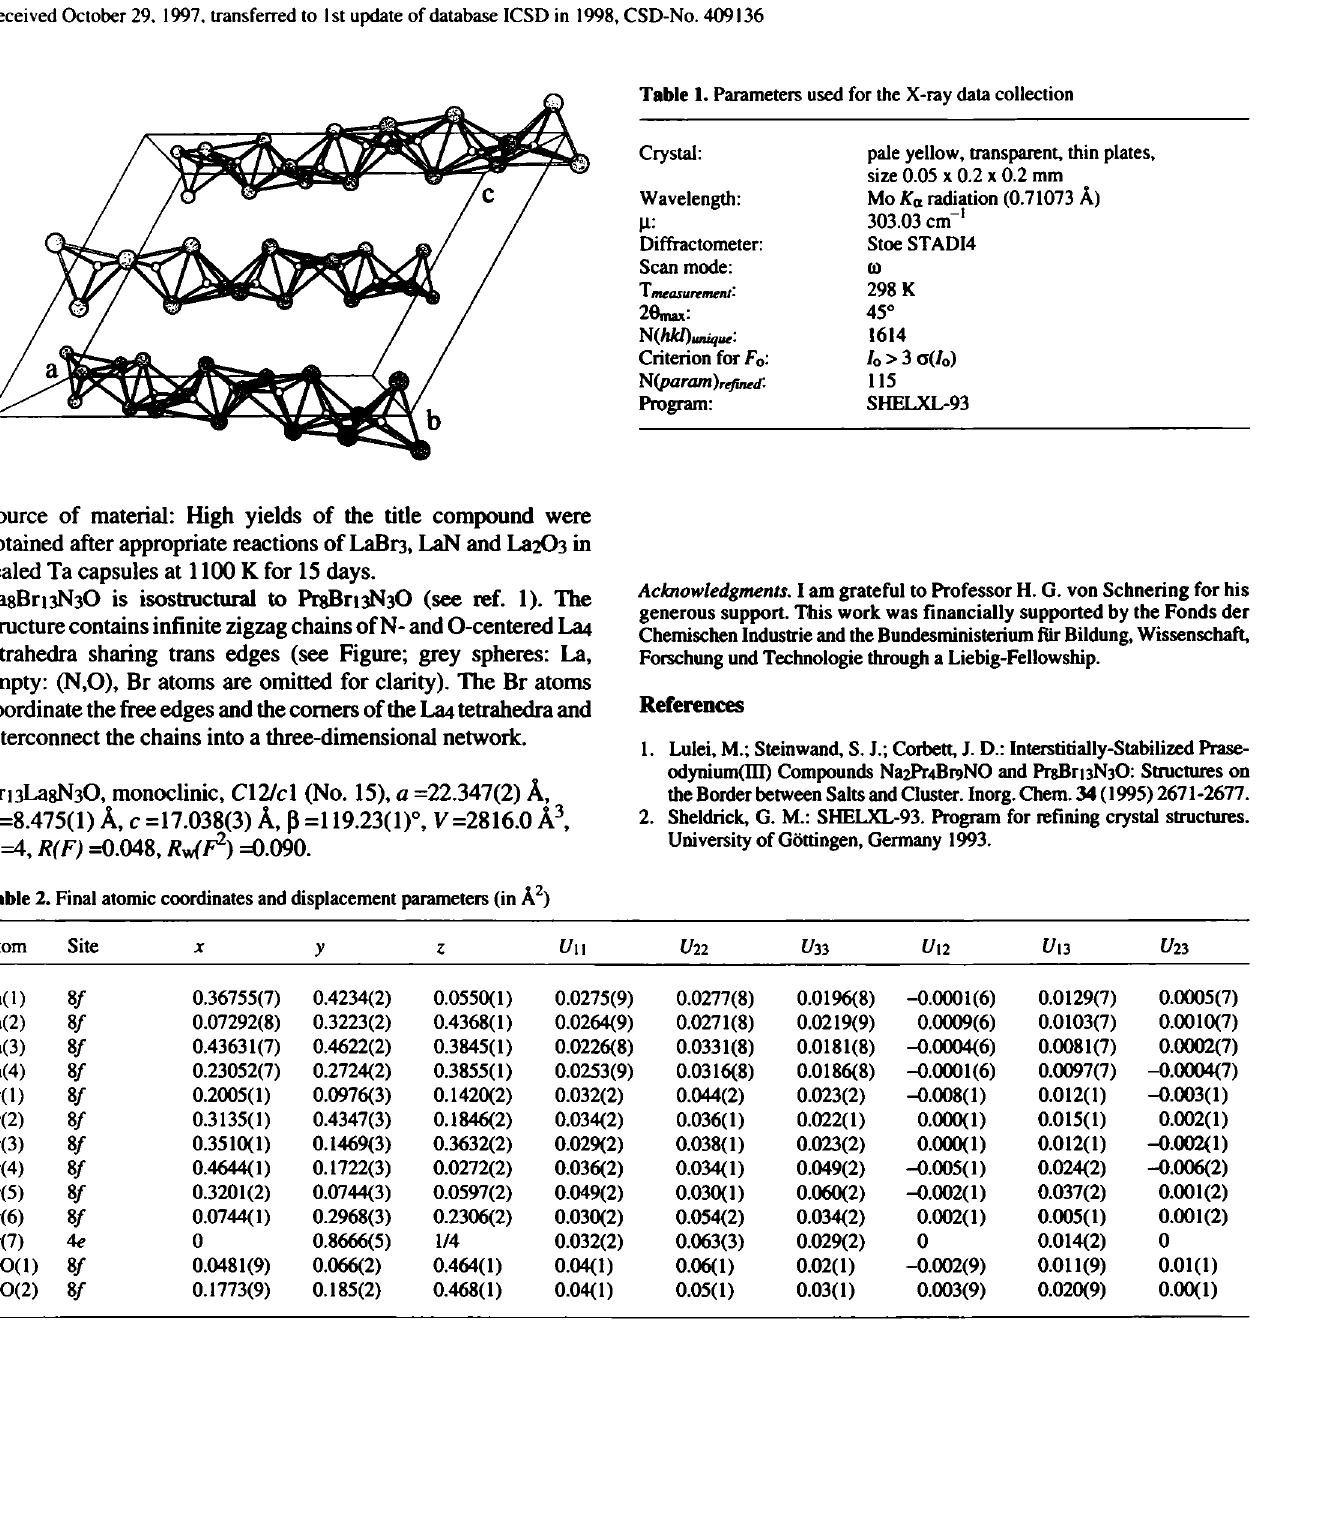
Table 1. Parameters used for the X-ray data collection Crystal: